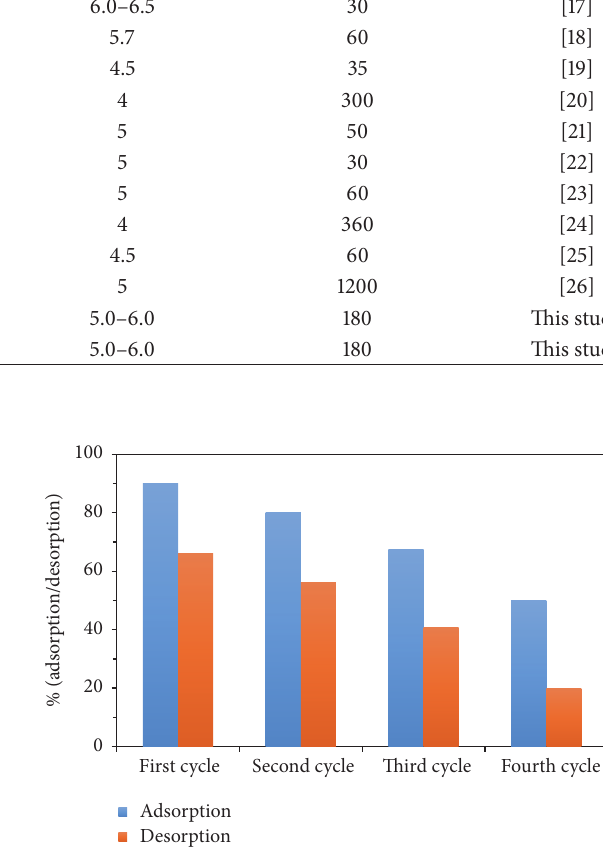
Figure 9: Percentage of Pb(II) adsorbed-desorbed per cycle ( 𝑇 = 25 ∘ C), with ACS